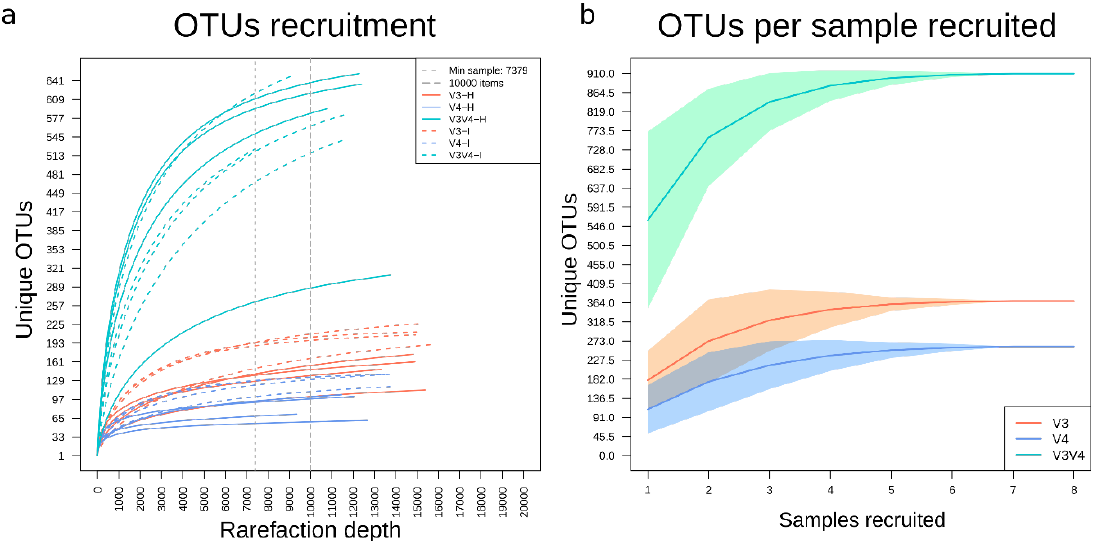
Figure 4. OTU recruitment at different rarefaction depths and number of samples. ( a ) Recruitment plot depicting the total number of unique OTUs captured by each sample in the gg97 BioSet. Each colored line represents a sample type (organ and region). H stands for hepatopancreas, I for intestine (intestine). The size of the smallest sample is marked with vertical dashed lines, as well as the 10,000 reads mark. ( b ) OTUs samples recruitment per region. The mean and density were calculated over OTUs 10,000 iterations.